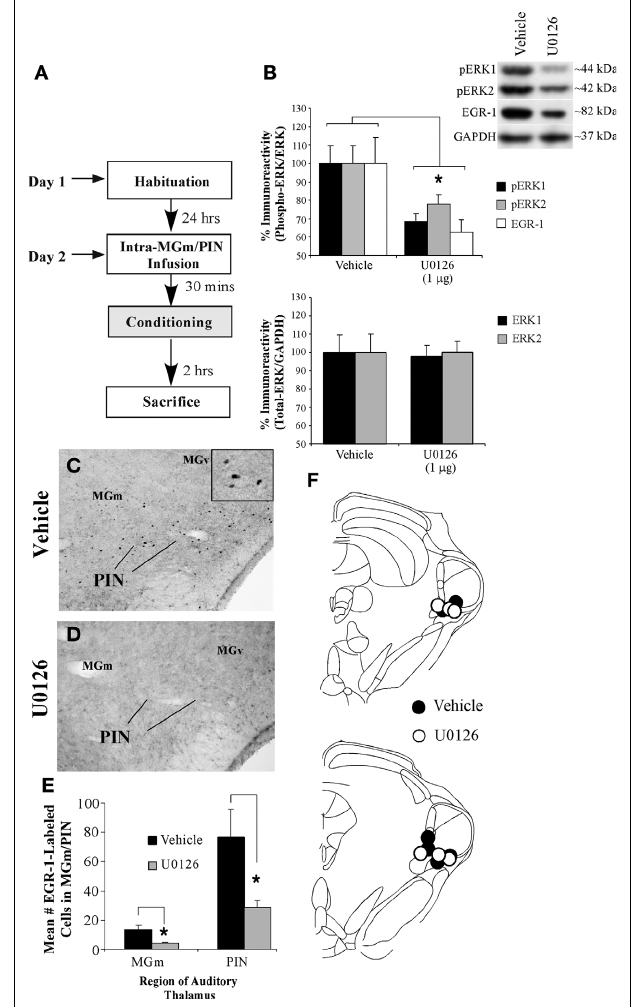
FIGURE 2 | Training-induced expression of EGR-1 in the MGm/PIN is impaired by intra-MGm/PIN infusion of a MEK inhibitor. (A) Schematic of the behavioral protocol. (B) Western blot analysis of phospho-ERK1 (black bars), phospho-ERK2 (gray bars), and EGR-1 proteins (white bars) in the MGm/ PIN of 50% DMSO vehicle ( n = 5) and U0126-infused groups ( n = 7) following fear conditioning. * p < 0.05 relative to vehicle groups. Representative blots can be seen in the inset. (C–D) Representative 20X photomicrographs of immunolabeled EGR-1 neurons in the MGm/PIN of rats receiving vehicle or U0126 infusion, respectively. Higher-level magnifi cation of EGR-1 labeled neurons the vehicle-infused rat is shown in the inset of (C) . (E) Quantifi cation of EGR-1 labeled cells in the MGm/PIN of vehicle ( n = 6) and U0126-treated rats ( n = 6). * p < 0.05 relative to the vehicle group. (F) Cannula placements for rats given intra-MGm/PIN infusion of either vehicle (black circles) or U0126 (white circles). Panels adapted from Paxinos and Watson